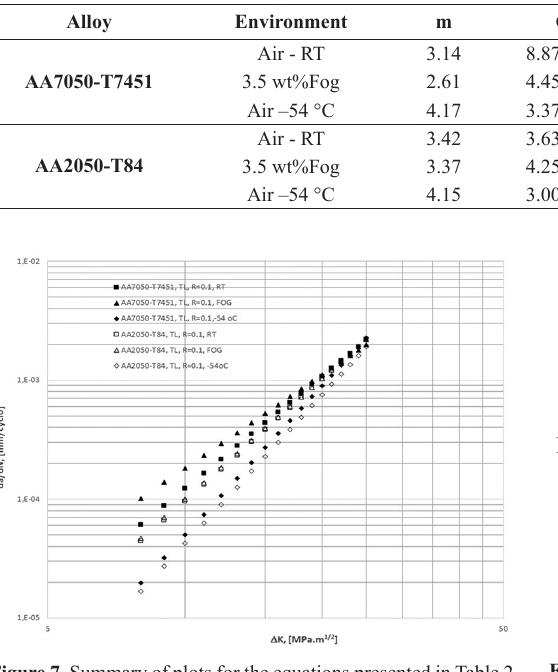
Figure 7. Summary of plots for the equations presented in Table 2 for FCG behavior considering both Al alloy and